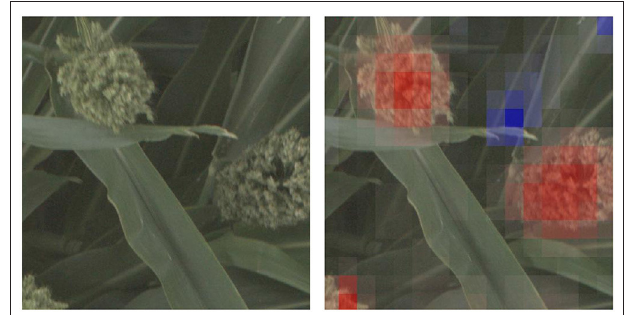
FIGURE 1 | We train deep convolutional neural network classifiers to predict whether an image of a sorghum crop contains a reference or alternate version of particular genetic marker, and then visualize why the network makes that prediction. In this figure, we show the visualization for why the neural network predicted an image showed a plant with an alternate version of a SNP that controls, among other phenotypes, panicle shape (Hilley et al., 2017)—the visualization highlights (in red) the panicle as an important feature in the networks